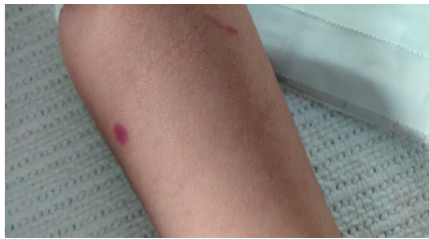
Figure 2: Case 2 shows the skin manifestations detected in the case.